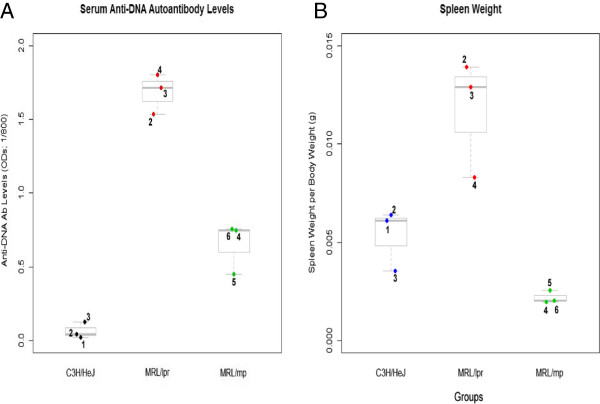
Immunological assessment for Study 1. (A) Three randomly selected mice from each of the groups were used for immunologic assessments (the numbers next to each dot represent the mouse number). ANOVA showed that anti-DNA autoantibody levels was significantly different between the groups (F = 112.953, p < 0.001) and using post-hoc analysis at p < 0.001 the 4 month MRL/lpr had significantly greater anti-DNA antibody levels compared to controls (measured at 1:800 serum dilution). (B) For the spleen weights there was a significant difference between the groups (F = 18.365, p < 0.003) and post-hoc analysis at p < 0.007 revealed that the 4 month MRL/lpr had significantly greater spleen weights (per body weight) compared to the MRL/mp and C3H/HeJ. In the box plot the middle line is the 50th percentile, the top of the box is the 75th percentile and the bottom of the box is the 25th percentile.